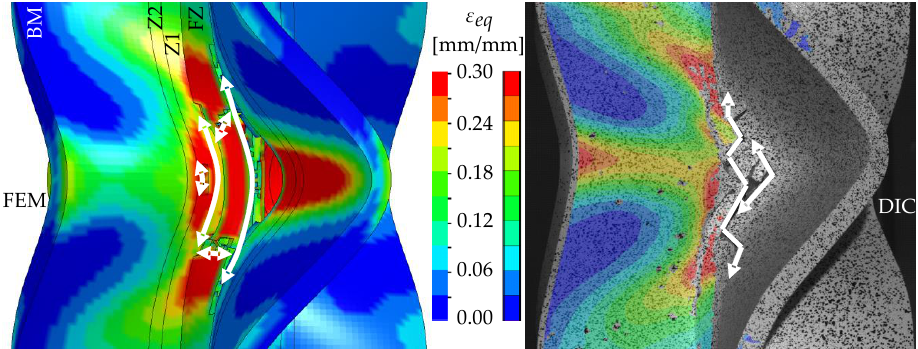
Figure 23. Comparison of crack growth in the FE model (BW criterion) and experiment at 45-mm displacement.